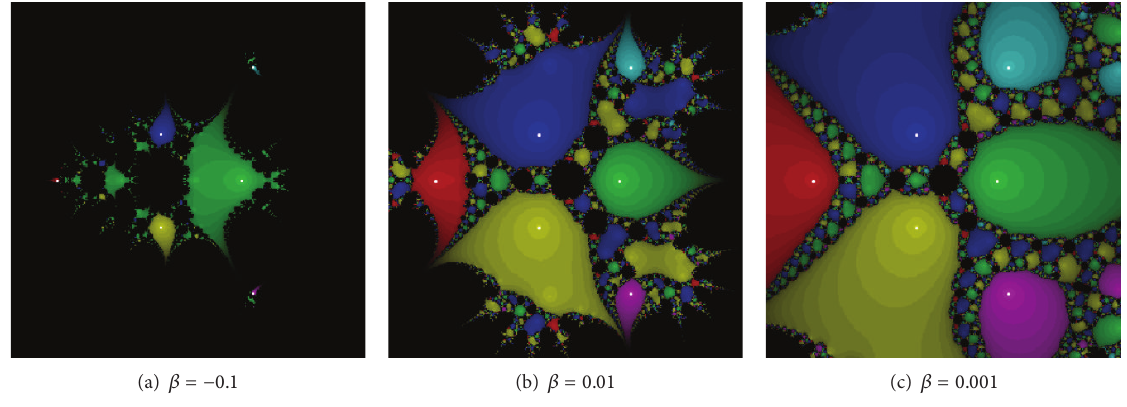
Figure 4: Scheme (3) for the test problem 2.